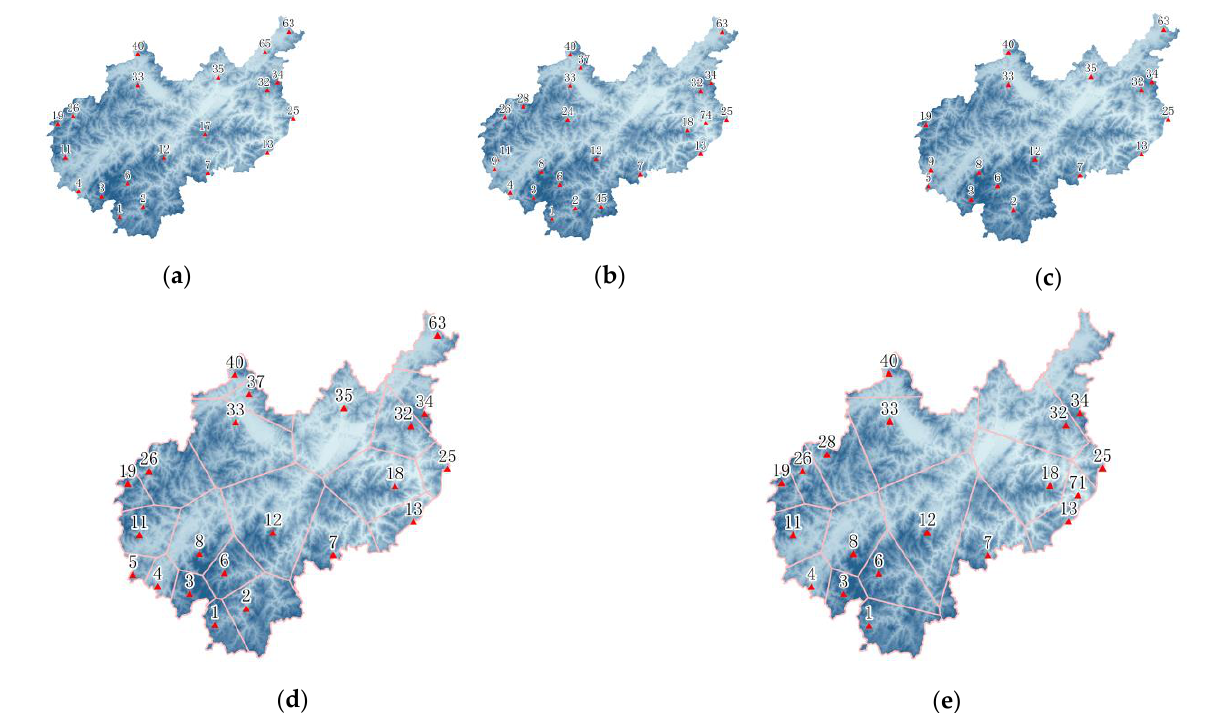
Figure 9. Optimized design results of 75 rain gauge stations with five types of data. ( a ) optimized station network with GPM IMERGE Early data; ( b ) optimized station network with GSMaP_NRT data; ( c ) optimized station network with PERSIANN − CCS data; ( d ) optimized station network with the three sets of satellite-based data combination; ( e ) optimized station network with rain gauge data.